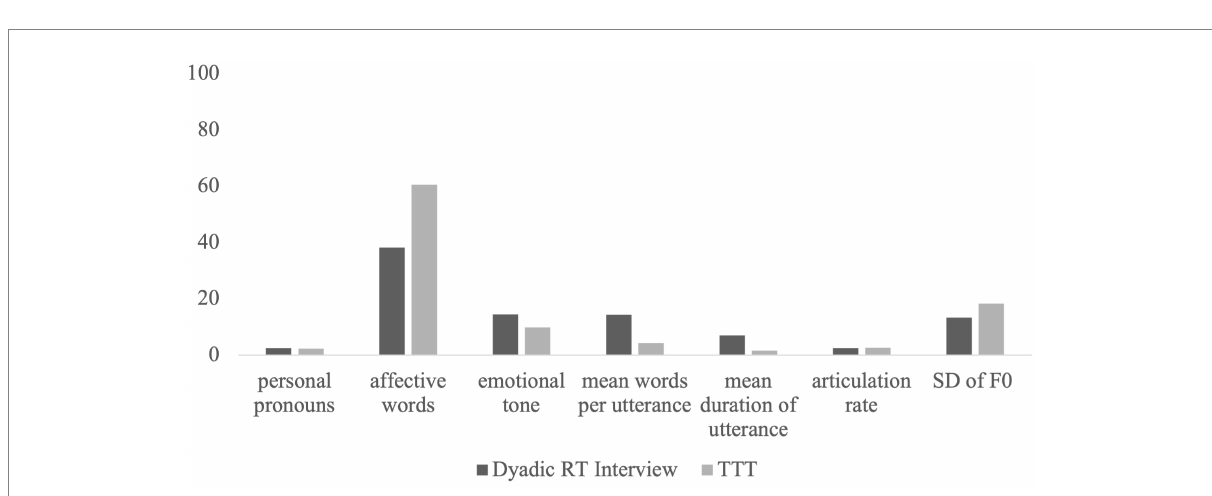
FIGURE 8 Mean of linguistic outcomes for Colette across two contexts: dyadic reminiscence therapy (RT) interview, and technology-driven group reminiscence therapy (TTT). The use of personal pronouns is measured as a percentage of all speech. Affective words incorporated both positive and negative emotive words and are measured as a percentagÍÍe of all speech. The emotional tone is measured from 0 (most negative) – 100 (most positive). The mean words per utterance is a numerical count value. The mean duration of utterance is measured in seconds. The articulation rate is the number of words spoken per second calculated from utterances. The standard deviation of fundamental frequency (SD of F0) is measured in